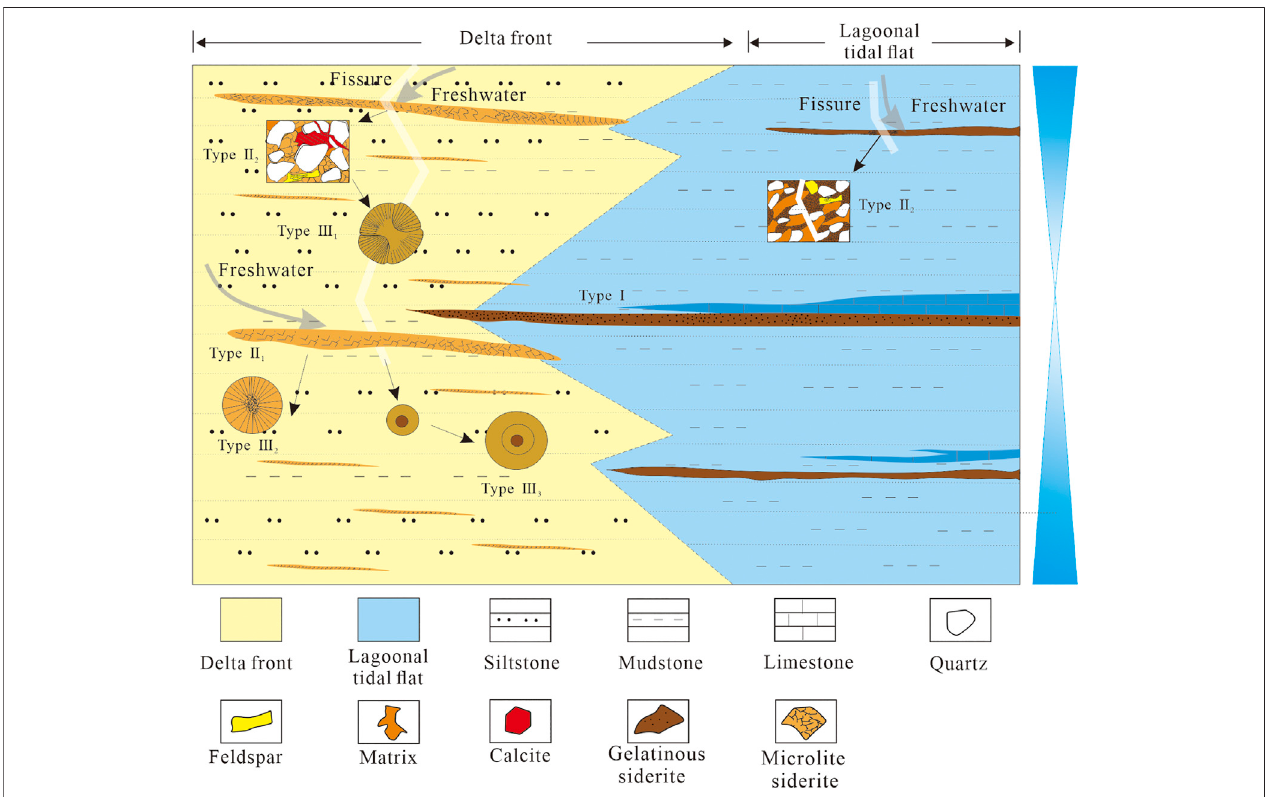
FIGURE 12 | Evolution model of different types of